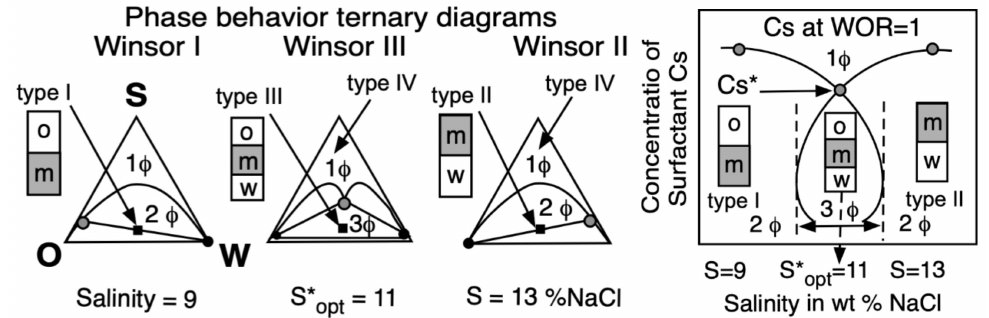
Figure 5. Top: Phase behavior at constant formulation cut for three cases of salinity (Winsor’s diagrams). Bottom: Solubilization as C S surfactant concentration to attain a single-phase microemulsion at constant WOR = 1 cut (vertical fish diagram). In both cases the formulation scan is carried out by a change in